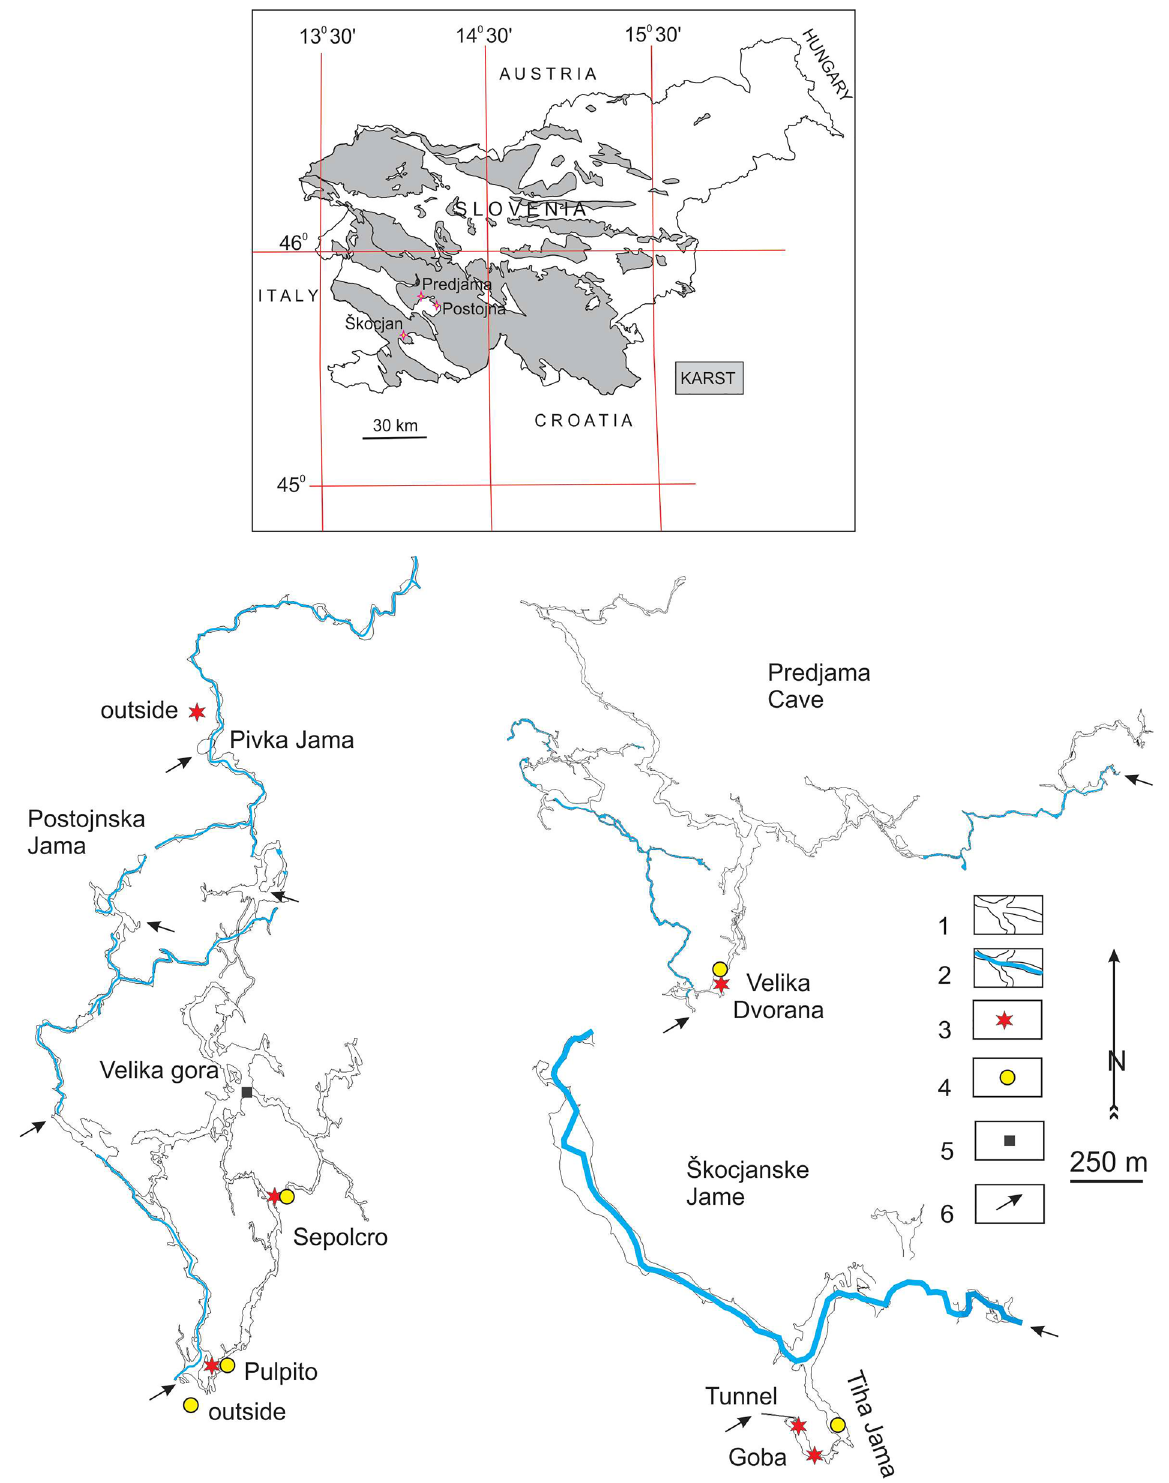
Fig. 1 Cave ground-plan maps with historical and current air tem- perature monitoring sites. 1—dry cave passages, 2—water cave passages, 3—current air temperature monitoring site,